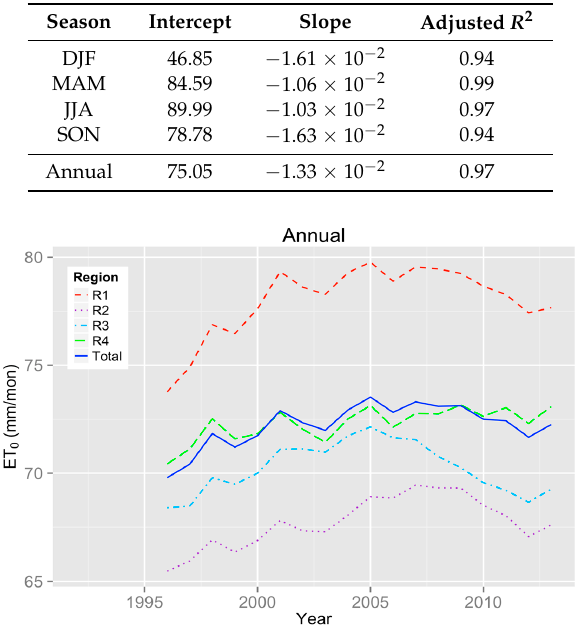
Figure 8. Annual trend in the 5-year moving average of monthly ET 0 in mm/month based on the extended climate data. The average for the whole study region is depicted as Total (solid blue line); the averages for R1, R2, R3, and R4 are presented using dashed red, dotted purple, dashed-dotted light blue, and dashed green lines, respectively.